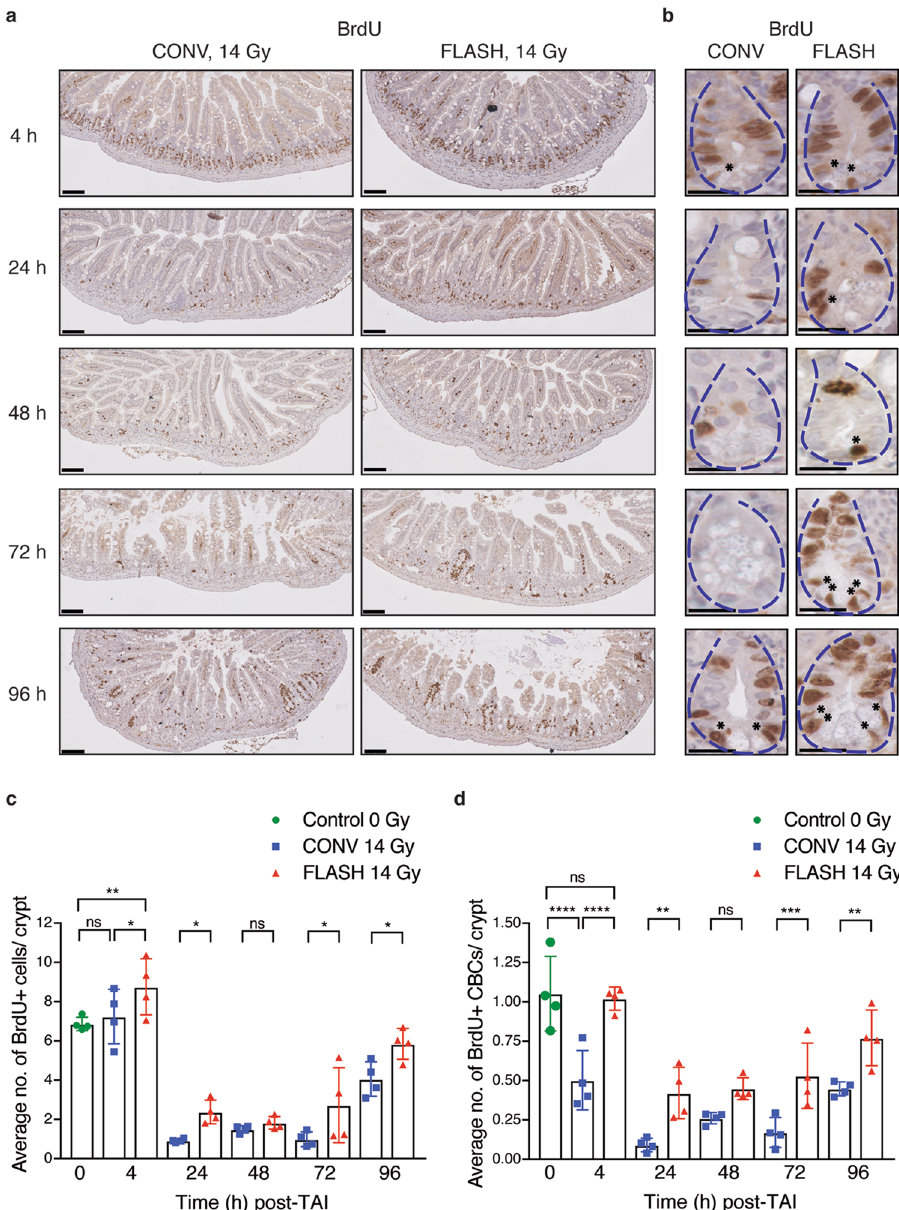
Figure 4. Abdominal FLASH irradiation alters the proliferation kinetics in crypt cell regeneration compared to CONV irradiation in non-tumor bearing mice. Cross sections of small intestines were analyzed for BrdU incorporation and crypt cell proliferation kinetics by BrdU IHC. ( a ) Representative images of BrdU stained jejunum cross sections at 10 × magnification at the indicated time points after sublethal 14 Gy TAI. Scale bar shows 100 μm. ( b ) 40 × magnified crypt images of the jejunum showing BrdU + crypt cells/CBCs at the indicated time points in CONV and FLASH irradiated animals. Scale bar shows 25 μm. Blue dotted lines outline the crypt structure. Black asterisks at the base of the crypt indicate the BrdU + proliferating CBCs in the stem cell zone. The rest of the brown nuclei within the crypt indicate BrdU + cells in the TA zone. ( c ) Quantification of the average number of BrdU + cells per crypt (includes BrdU + cells in both TA zone and stem cell zone). ( d ) BrdU + CBCs per crypt at 4, 24, 48, 72 and 96 h in unirradiated controls and after 14 Gy TAI, demonstrating relative early sparing of proliferating CBCs and more robust regeneration after FLASH vs . CONV irradiation. CBC cells were identified based on location at the + 1 to + 3 position wedged between Paneth cells and BrdU + CBCs indicated by black asterisks in the stem cell zone. Fifty crypts per circumference were quantified for BrdU + crypt cells and BrdU + CBCs. Three circumferences per mouse were analyzed (n = 4 mice per group). *p < 0.05, **p < 0.01, ****p < 0.0001; Comparisons by ordinary one-way ANOVA followed by Sidak’s multiple comparisons test. Error bars represent standard deviation of the